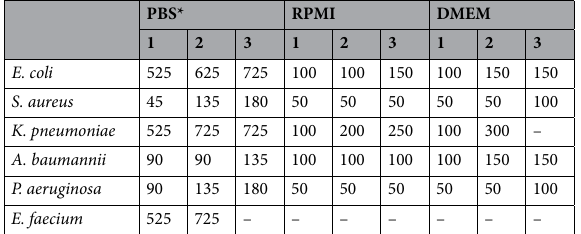
Table 2. Irradiation dose [J cm −2 ] per log reduction at 405 nm in comparison to the dark control. *Values derived from 26 .